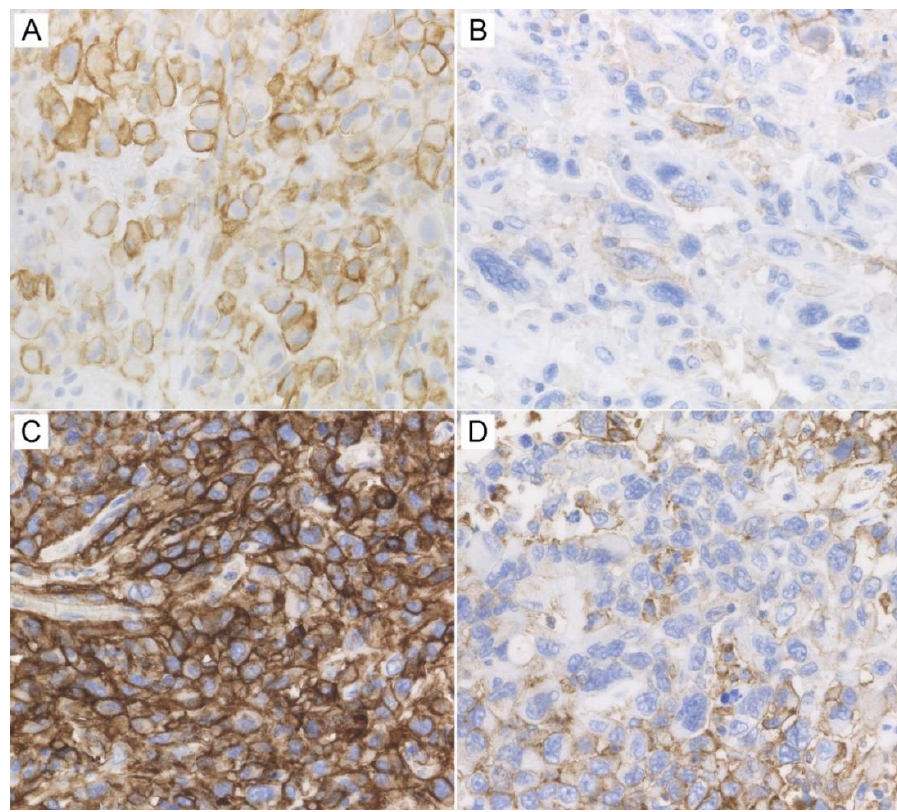
Figure 3. Dynamics of PD-L1 expression. High expression of PD-L1 on cancer cells in patients 1 ( A ) and 2 ( C ), which allowed administration of Pembrolizumab. A remarkable decrease of PD-L1 expression in patients 1 ( B ) and 2 ( D ) after immunotherapy. Immunohistochemistry, ×400 ( A – D ). Table 1. Immunohistochemical expression of PD-L1 and selected biomarkers in non-small-cell lung carcinoma specimensbefore and after immunotherapy.